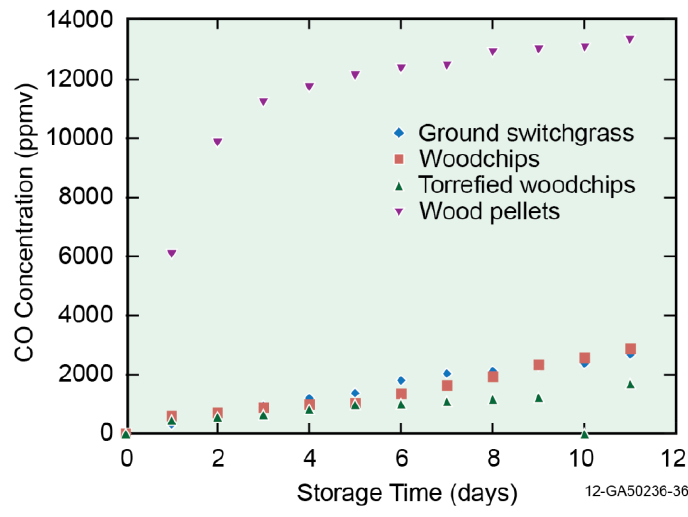
Figure 3. CO concentration at 40 °C storage temperature.